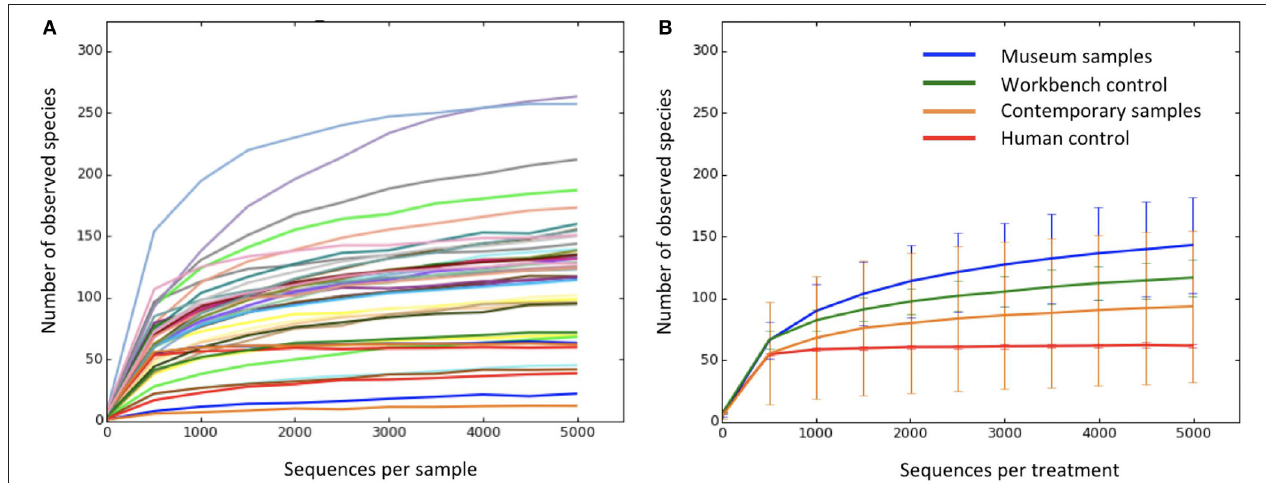
FIGURE 3 | Rarefaction plots of the Alpha diversity of (A) all samples and (B) average number of observed species for each treatment group (Museum samples, contemporary samples, workbench control and human control). Error bars indicate the standard